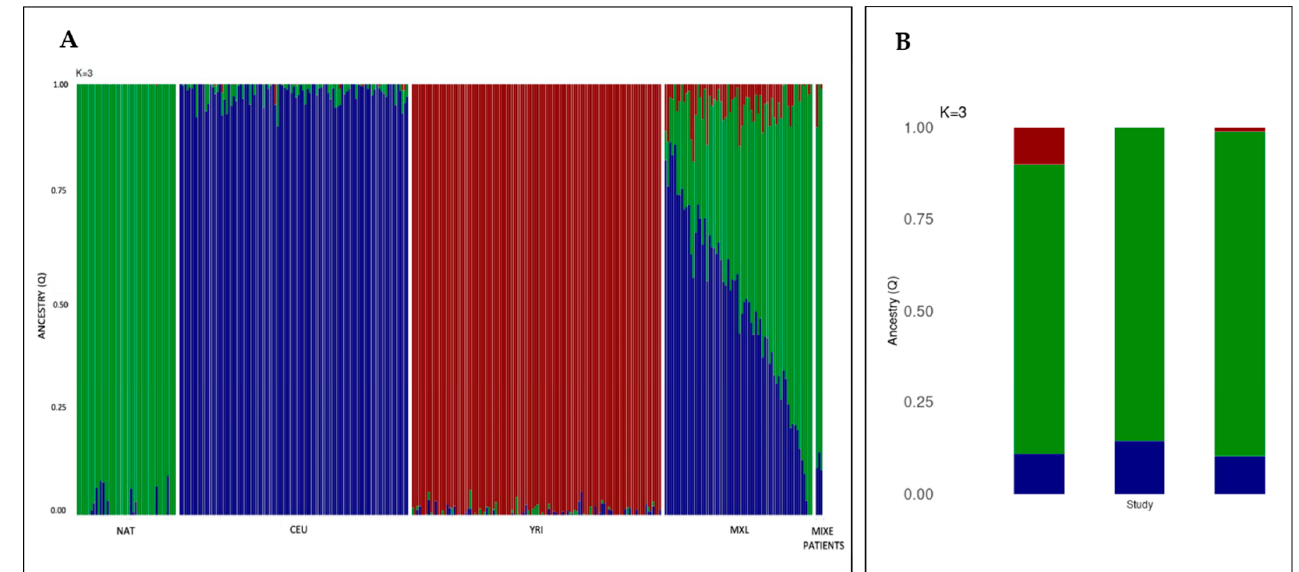
Figure 2. Mixe patients with FA present an ancestry pattern that have the hallmarks of the genetic diversity of the Mexican population. ( A ) Barplot showing the inference of global ancestry for the Mixe and Mexican individuals using ADMIXTURE, population reference panels include NAT, CEU, and YRI (K = 3 model). Each individual is depicted as a vertical bar. Colors represent the percentage of ancestry assigned to each cluster for each individual. Green, blue, and red colors indicate Native- Americans (NAT), Northern Europeans (CEU), and Yorubas (YRI) populations, respectively. The two panels located at the extreme right of the figure show the three-way ancestry components for the admixed Mexican (MXL) population and the Mixe patients (last three bars). ( B ) Detailed bar plot of the three Mixe patients with FA, left to right FANC32, FANC143 and FANC155. Table 3. Founder pathogenic variants reported in FANCG